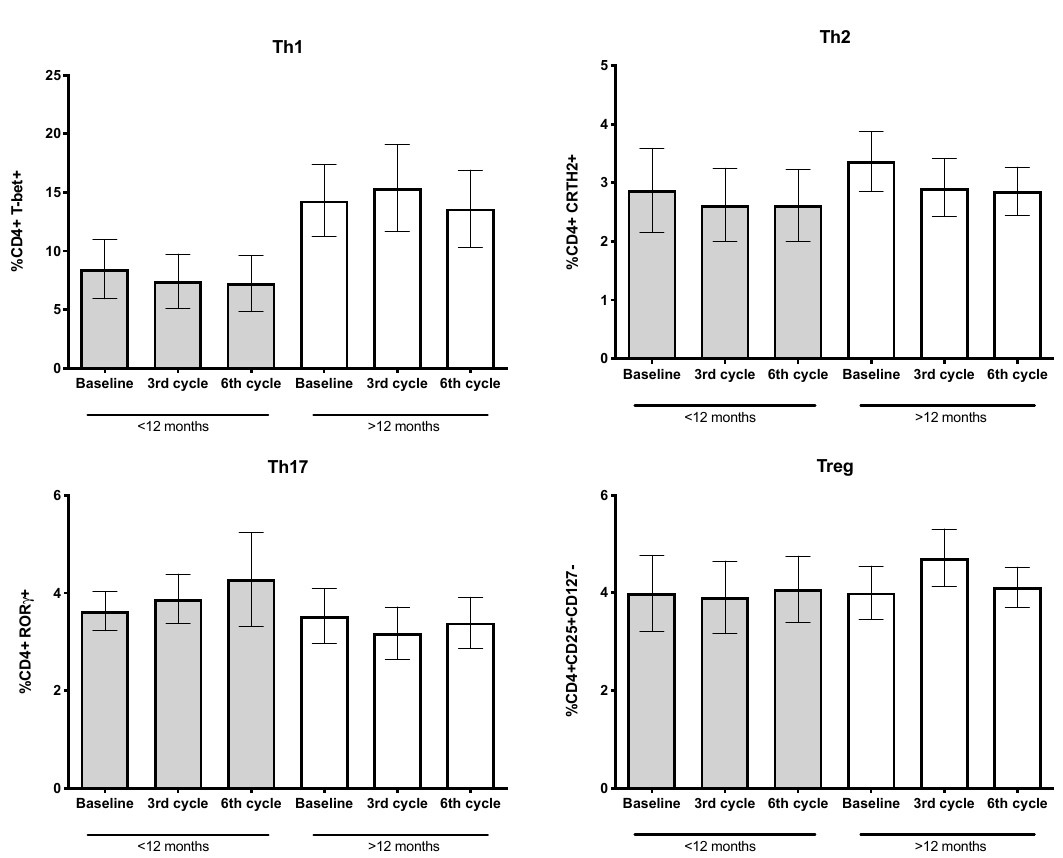
Figure 7. Percentages of CD4+ T-lymphocyte subpopulations. Th1, Th2, Th17, and Treg were quantified by detecting membrane and nuclear markers. Data obtained from patient groups with shorter (<12 months, n = 11) and longer (>12 months, n = 19) OS is shown. Mean ± SEM are indicated.